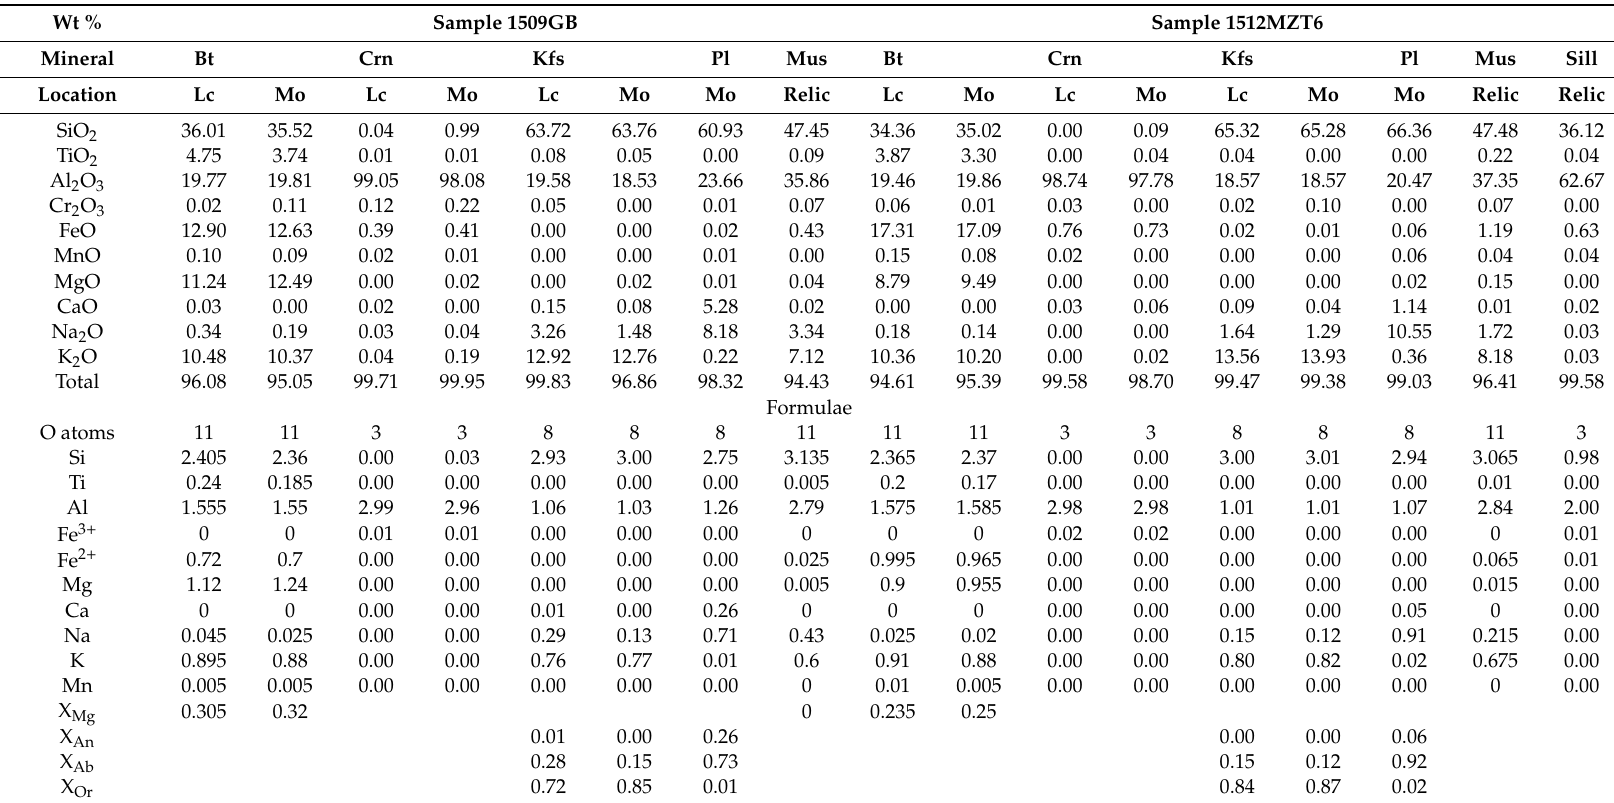
Table 2. Electron microprobe analyses of representative minerals from the corundum-bearing rocks in the